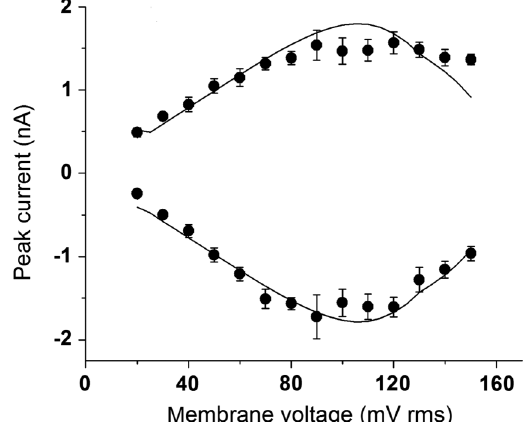
FIG. 12. Peak current for (cid:3) ¼ 100 Hz . The two branches (posi- tive and negative current swings) are approximately symmetric, but the curves are nonlinear in the driving amplitude V current saturates and even decreases as V lines represent the model with identical parameter values to those in Figs. 8 and 11 except for the frequency of excitation (cid:3) .